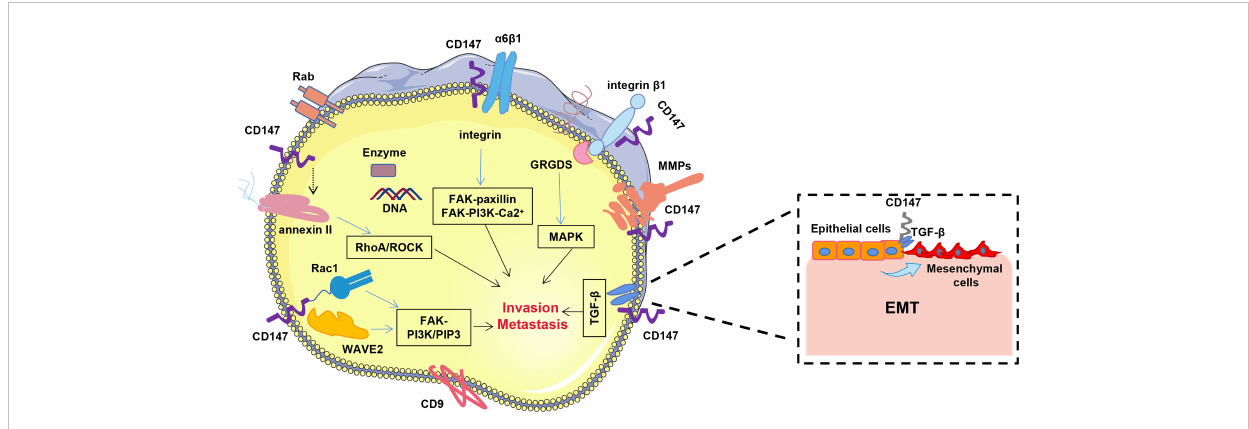
FIGURE 2 CD147 promotes hepatocellular carcinoma invasion and metastasis. CD147 promotes HCC invasion and metastasis mainly through FAK-PI3K-Ca2 + , RhoA/ROCK, FAK-PI3K/PIP3,TGF- b and MAPK signaling